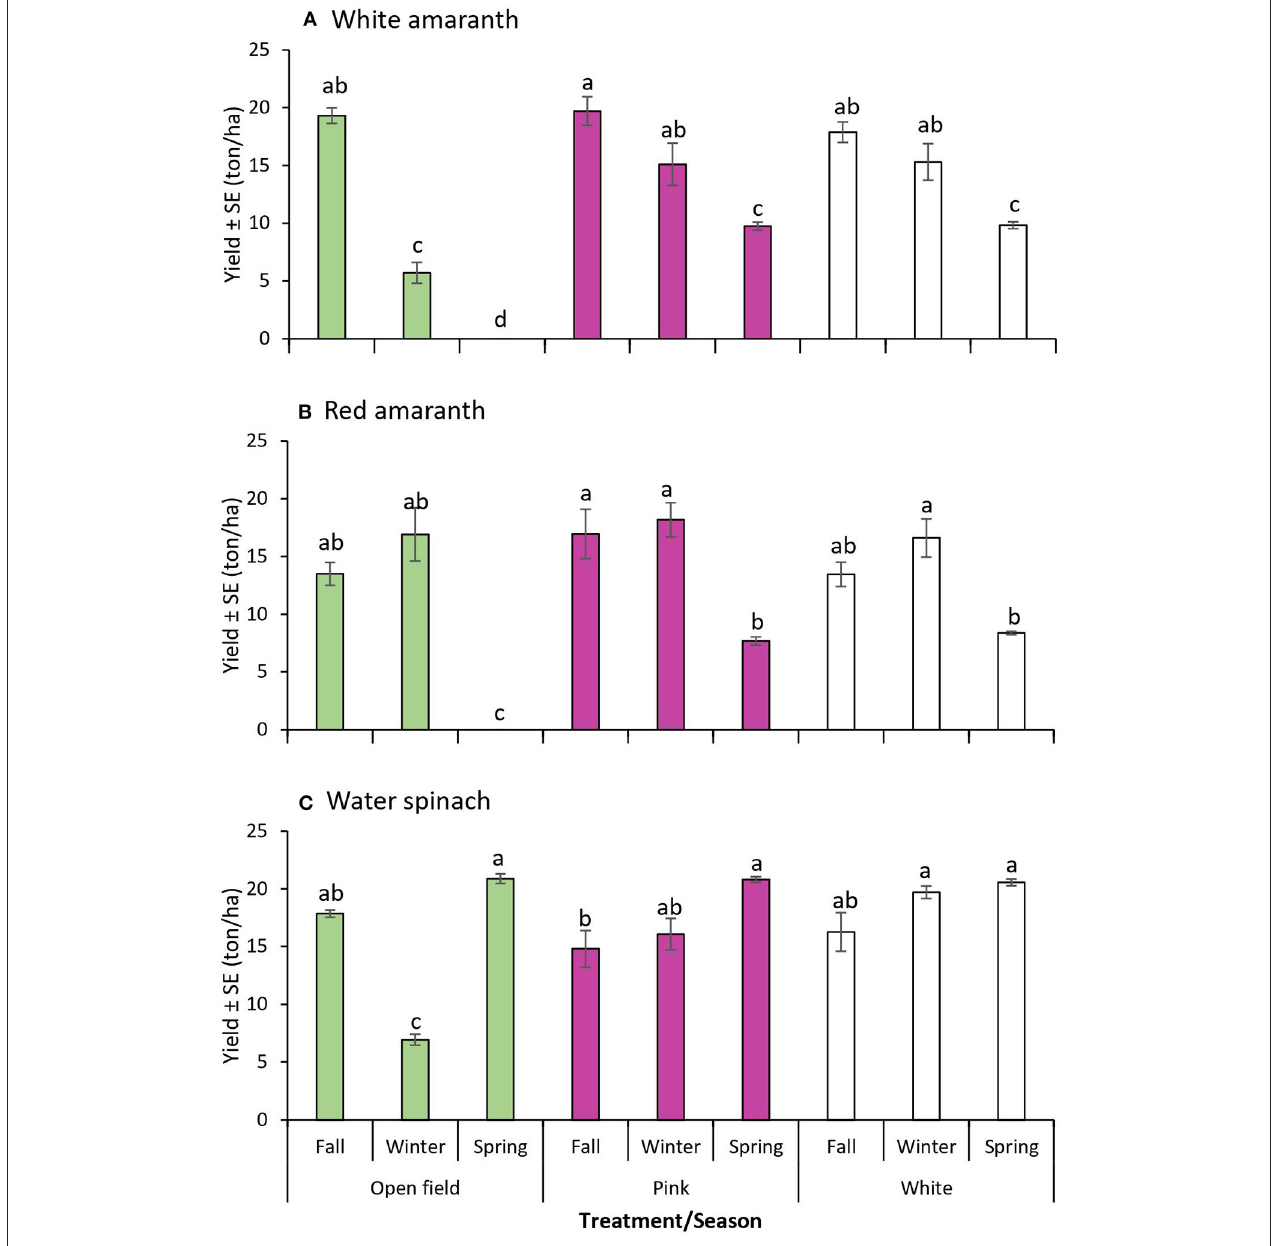
FIGURE 1 | Yield ± SE (ton/ha) of leafy vegetables grown under different production conditions. (A) White amaranth, (B) Red amaranth, (C) Water spinach. Means represent average of four replications in each treatment/season. Means followed by the same letter(s) in a crop are not significantly different ( p < 0.05).